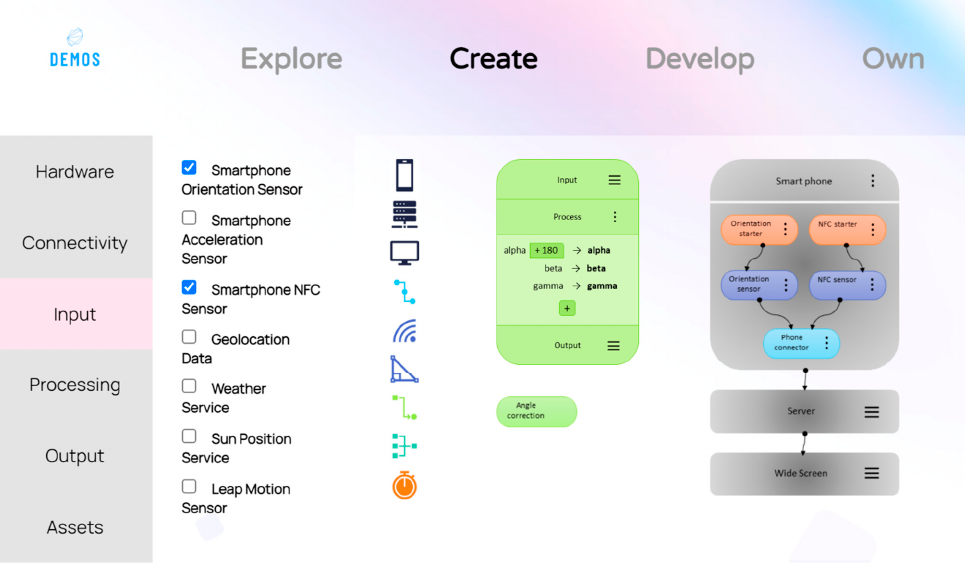
Figure 11. The graphic user interface when creating the MusExp app for multimodal interaction with the connectivity pattern for disconnecting the previous user.